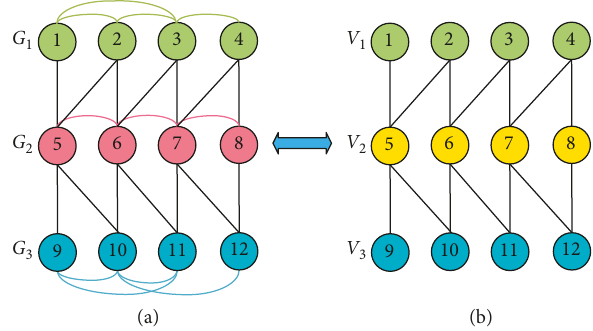
Figure 1: Graphical illustrations of (a) a multilayer network consisting of three networks G network consisting of three partite sets V